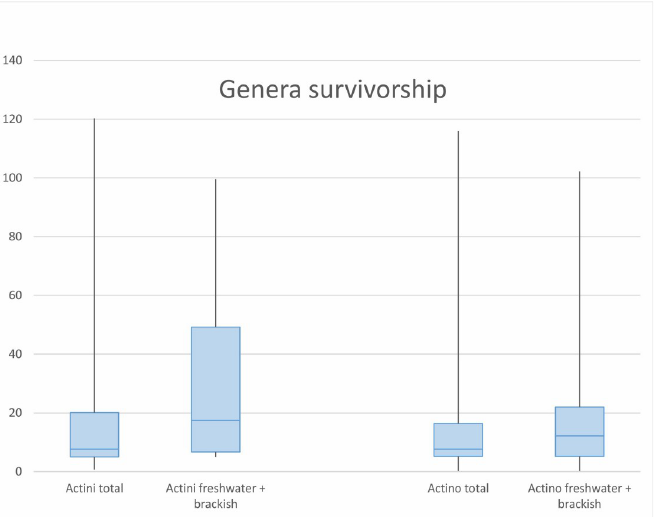
Fig 7. Comparison of genera survivorship in myrs between coelacanths (left) and ray-finned fish (right), distinguished between paleoenvironments. Abbreviations: Actini, Actinistia (coelacanths); Actino, Actinopterygii (ray-finned